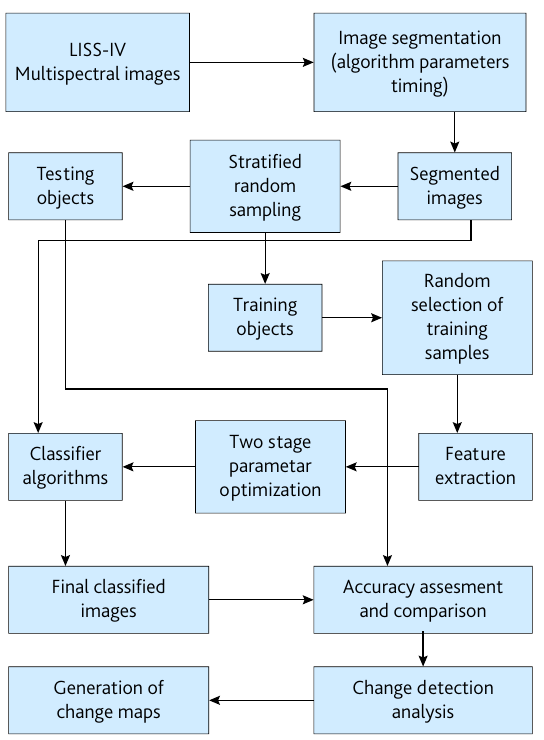
Figure 2. Flow chart of proposed OBCD